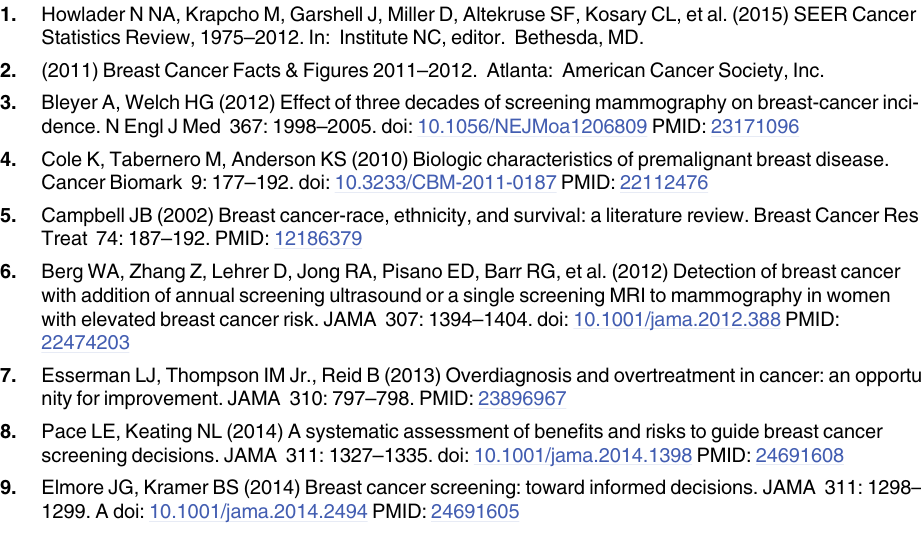
S1 Fig. ROC curves for Age & BI-RADS-Inclusive Models. Area under the curve (AUC) shown for each model in the inset. S1 Table. Performance of models utilizing subject age. P-values are shown for the compari- sons of Combined vs. Independent TAAb and Combined vs. Independent SPB S2 Table. Raw data for all samples and